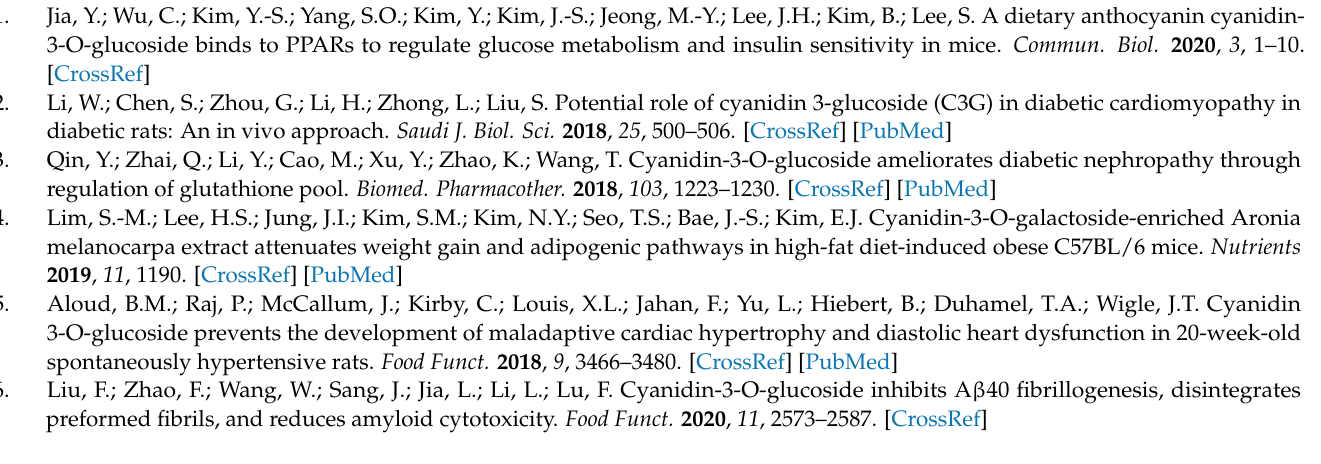
Table S4a: Results of 487 DEGs (upregulated in ADM mice+C3G vs. ADM mice comparison) in panther enrichment analysis for molecular function; Table S4b: Results of 487 DEGs (upregulated in ADM mice+C3G vs. ADM mice comparison) in panther enrichment analysis for cellular compo- nents; Table S4c: Results of 487 DEGs (upregulated in ADM mice+C3G vs. ADM mice comparison) in panther enrichment analysis for protein class; Table S4d: Results of 487 DEGs (upregulated in ADM mice+C3G vs. ADM mice comparison) in panther enrichment analysis for pathways; Table S4e: Results of 487 DEGs (upregulated in ADM mice+C3G vs. ADM mice comparison) Reac- tome pathway analysis; Table S4f: Results of 487 DEGs (upregulated in ADM mice+C3G vs. ADM mice comparison) in panther enrichment analysis for biological function; Table S5a: Results of 53 DEGs (downregulated in ADM mice+C3G vs. ADM mice comparison) according to molecular function in panther enrichment analysis for molecular function; Table S5b: Results of 53 DEGs (downregulated in ADM mice+C3G vs. ADM mice comparison) according to cellular component in panther enrichment analysis for cellular components; Table S5c: Results of 53 DEGs (downregu- lated in ADM mice+C3G vs. ADM mice comparison) according to protein class in panther enrich- ment analysis for protein class; Table S5d: Results of 53 DEGs (downregulated in ADM mice+C3G vs. ADM mice comparison) according to pathways in panther enrichment analysis for pathways; Table S5e: Results of 53 DEGs (downregulated in ADM mice+C3G vs. ADM mice comparison) in panther enrichment analysis for biological function; Table S6a: PPN1 Network stats of protein–protein interaction network from STRING; Table S6b: PPN2 Network stats of protein–protein interaction network from